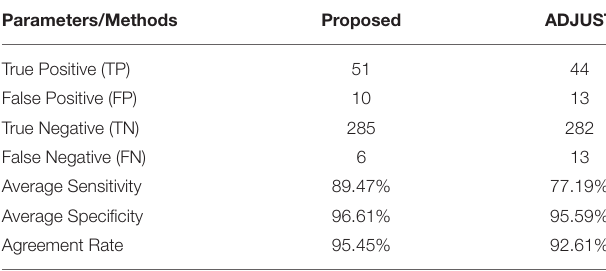
TABLE 2 | Performance comparison of the proposed method and ADJUST for identification of ocular artifact related ICs with manual detection.